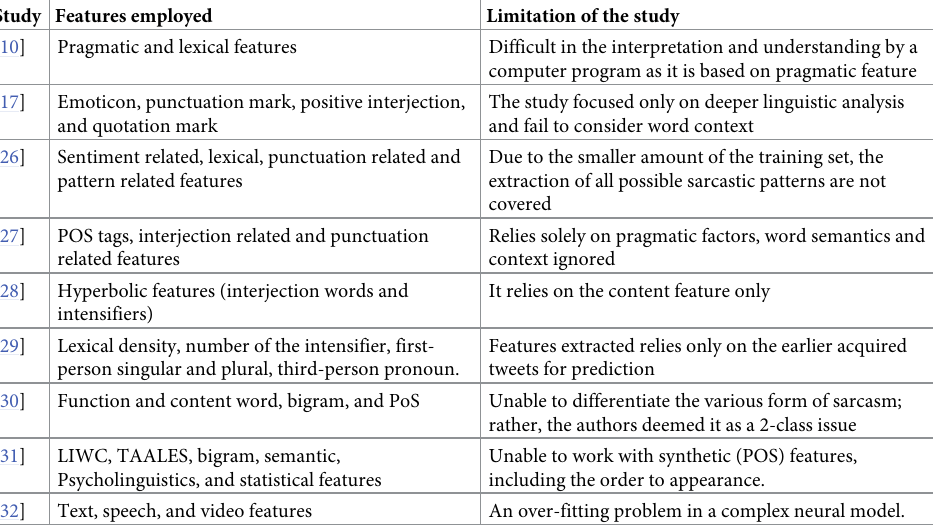
Table 2. Summary of the related works on feature engineering aspect for sarcasm